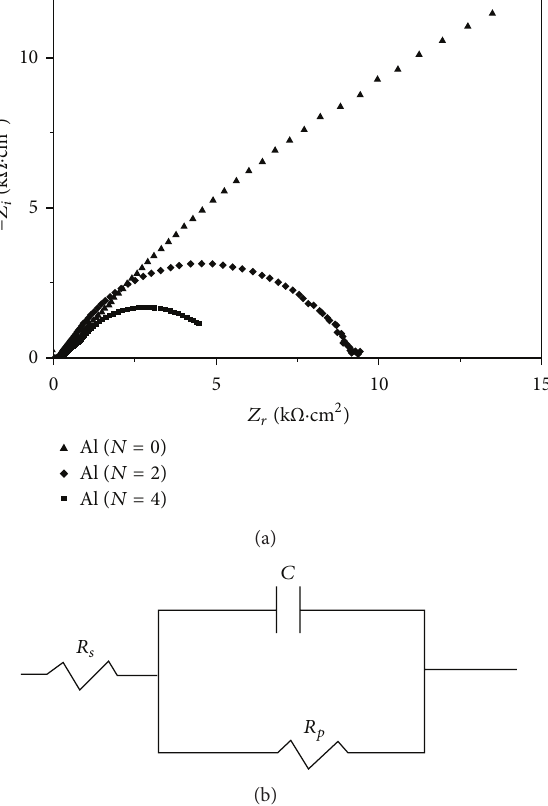
Figure6:ImpedancespectraoftheECAP’edsamplesandunpressed sample obtained at open circuit (a) and 25 ∘ C in solution of 3.5wt.% NaCl solution at pH 6.4 and the electrical equivalent circuit